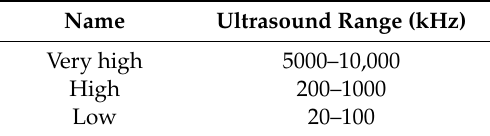
Table 1. Frequency ranges used in the ultrasonic process. Taken from